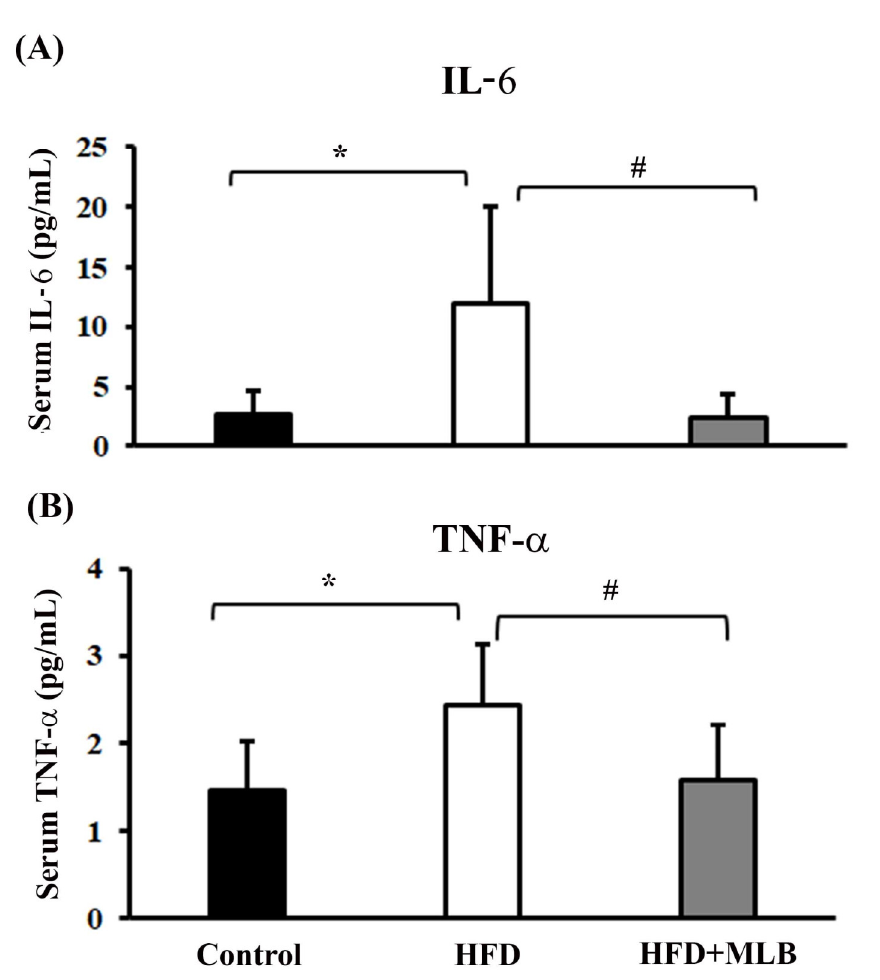
Figure 3. MLB supplementation reduced HFD-induced proinflammatory cytokines. At the end of the experiment, serum samples were subjected to measurements of IL-6 ( A ) and TNF-α ( B ) with commercially available enzyme immunosorbent assay kits. * p < 0.05 vs. control group. # p < 0.05 vs. HFD group. n = 8.